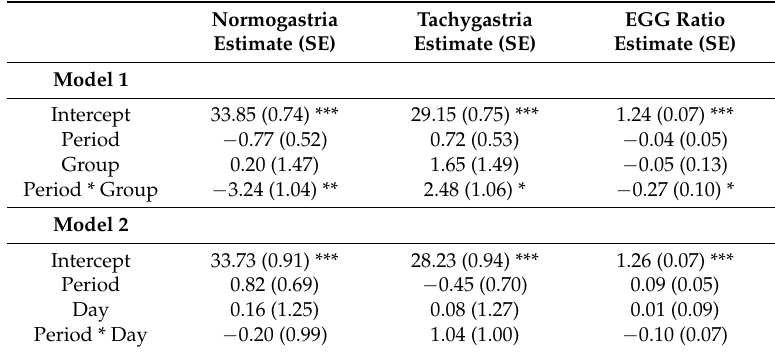
Table 3. Hierarchical linear model estimates for the effects of period, group and day on EGG parameters (Model 1: EGG period x group (OBE T1 versus NW), Model 2: period x day in OBE only).